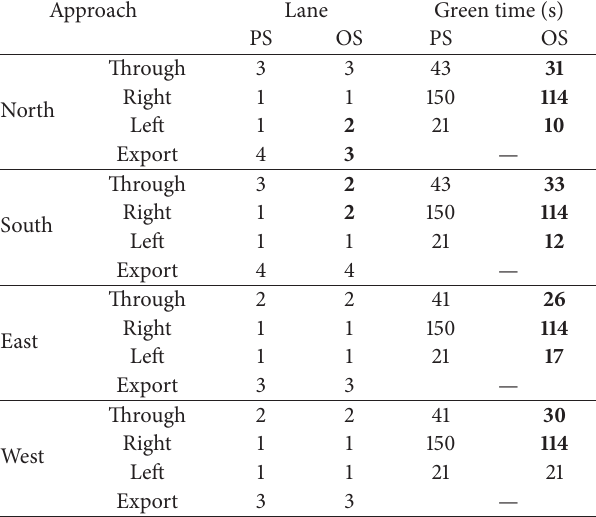
Table 4: Optimization for common.